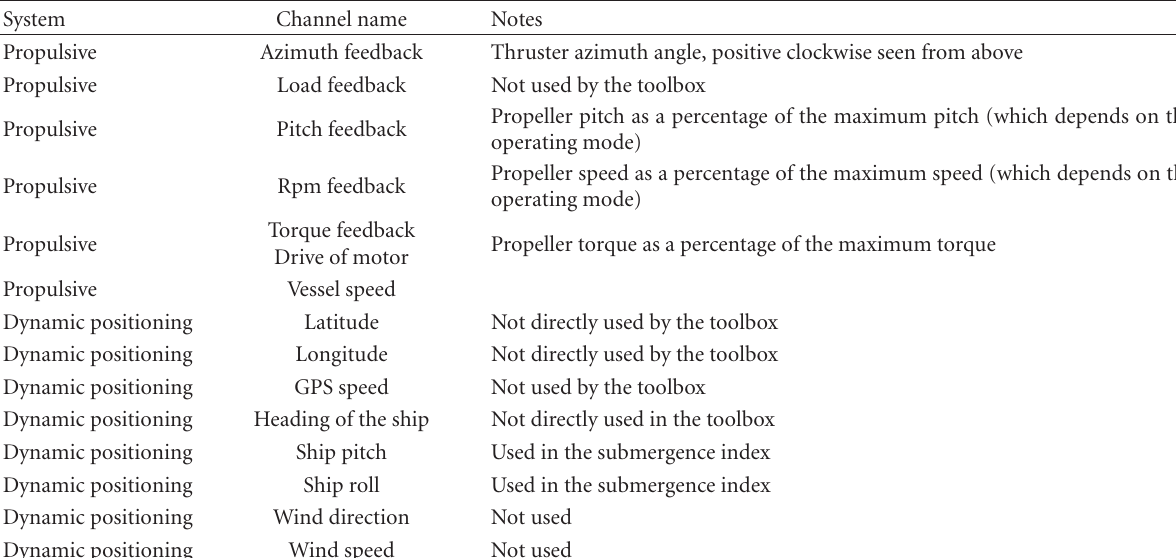
Table 1: List of available